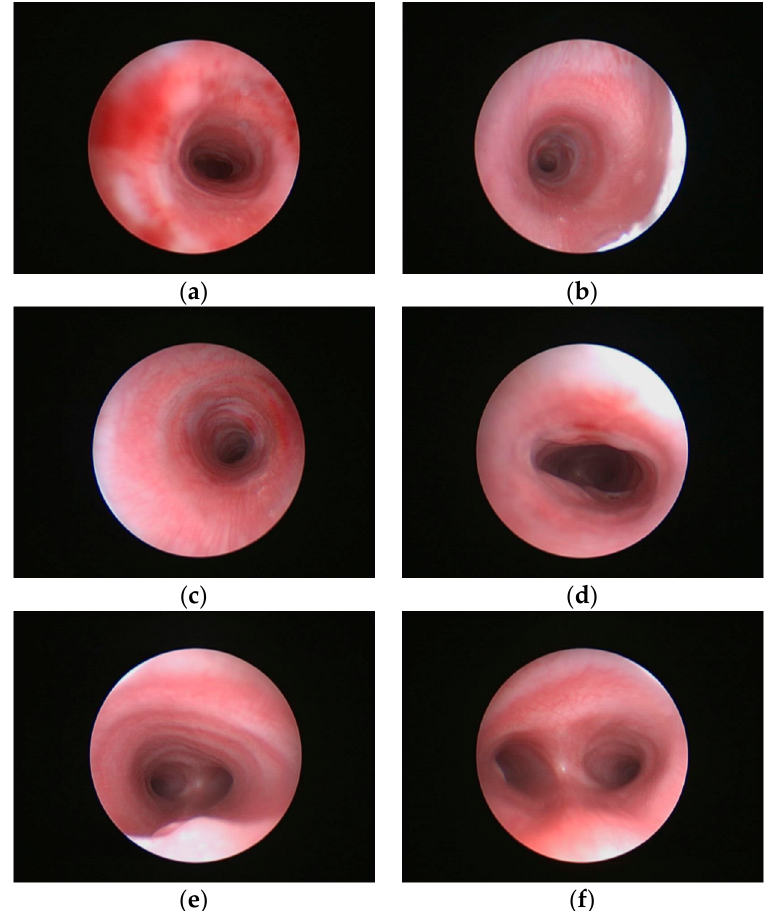
Figure 1. Direct bronchoscopic images: (a) to (f) – multiple bronchoscopic images revealing traumatic injury in (a) and multiple tracheal rings best seen in (b), (c) & (e).